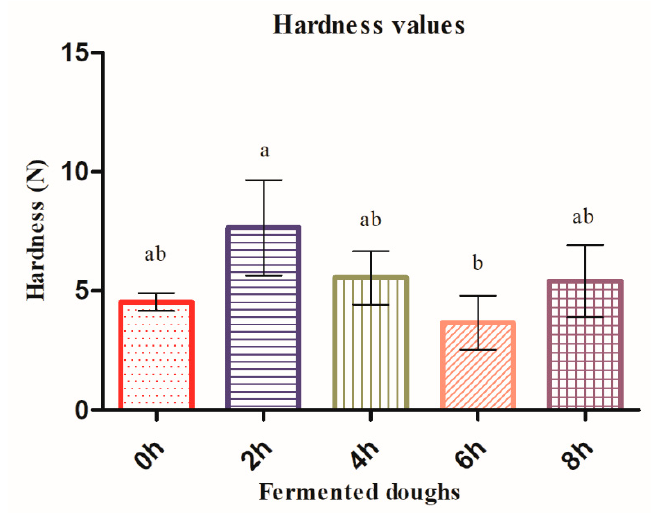
Figure 5. Hardness values obtained in biscuits made from fermented flour. Data is mean of three replicates (±standard deviation). a , b different letters indicate significant differences ( p < 0.05). Table 1. Results of chemical composition analyzes obtained from biscuits from flours fermented for di ff erent amounts of time. Data is mean of three replicates ( ± standard deviation). a, b di ff erent letters indicate significant di ff erences within the same column ( p <